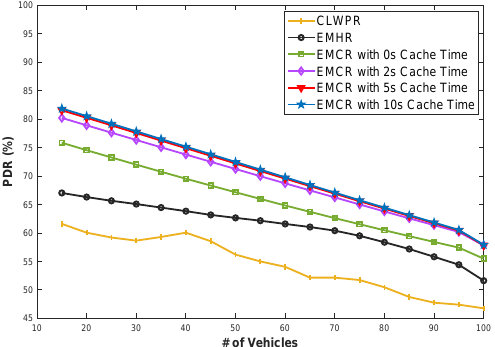
Figure 12. Packet delivery ratio vs. Number of Vehicles.